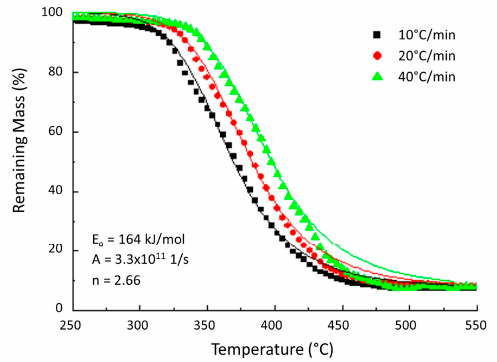
Figure 1. Comparison between the predicted and measured remaining mass based on Thermogravimetric results [21].